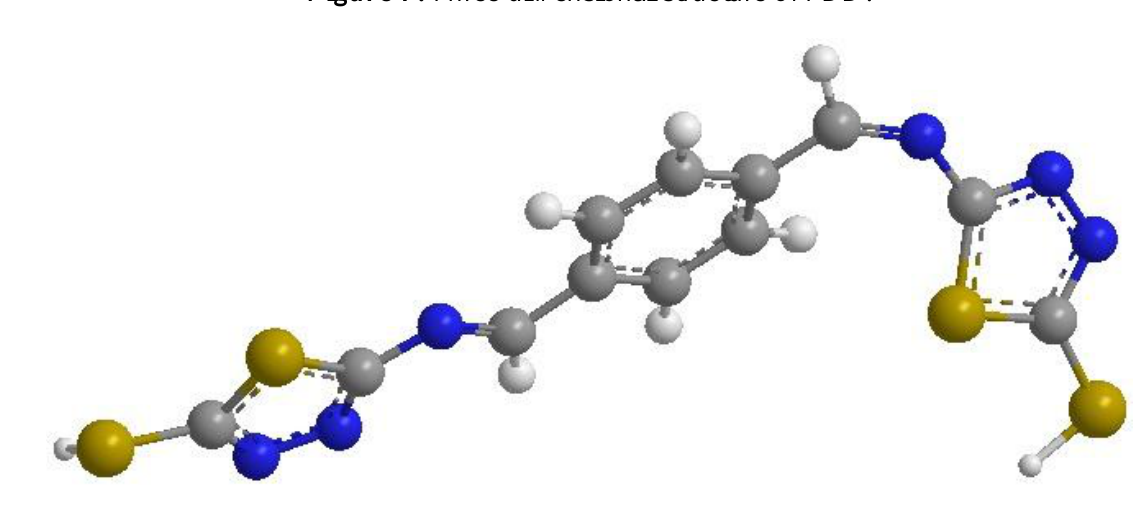
Figure 7. Three dimensional structure of